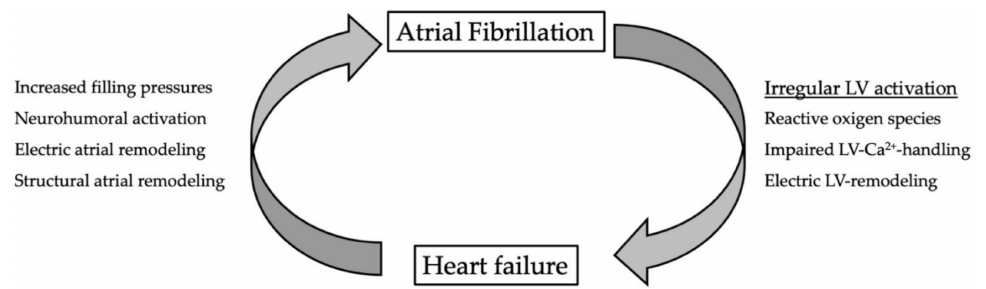
Figure 2. Vicious circle between atrial fibrillation and heart failure. Irregular activation impairs left-ventricular function by intracellular production of reactive oxygen species. This leads to impaired LV-Ca 2+ -handling and electric remodeling. In heart failure, filling pressures are increased and the neurohumoral cascade is activated. Both contribute to electric and structural remodeling of the